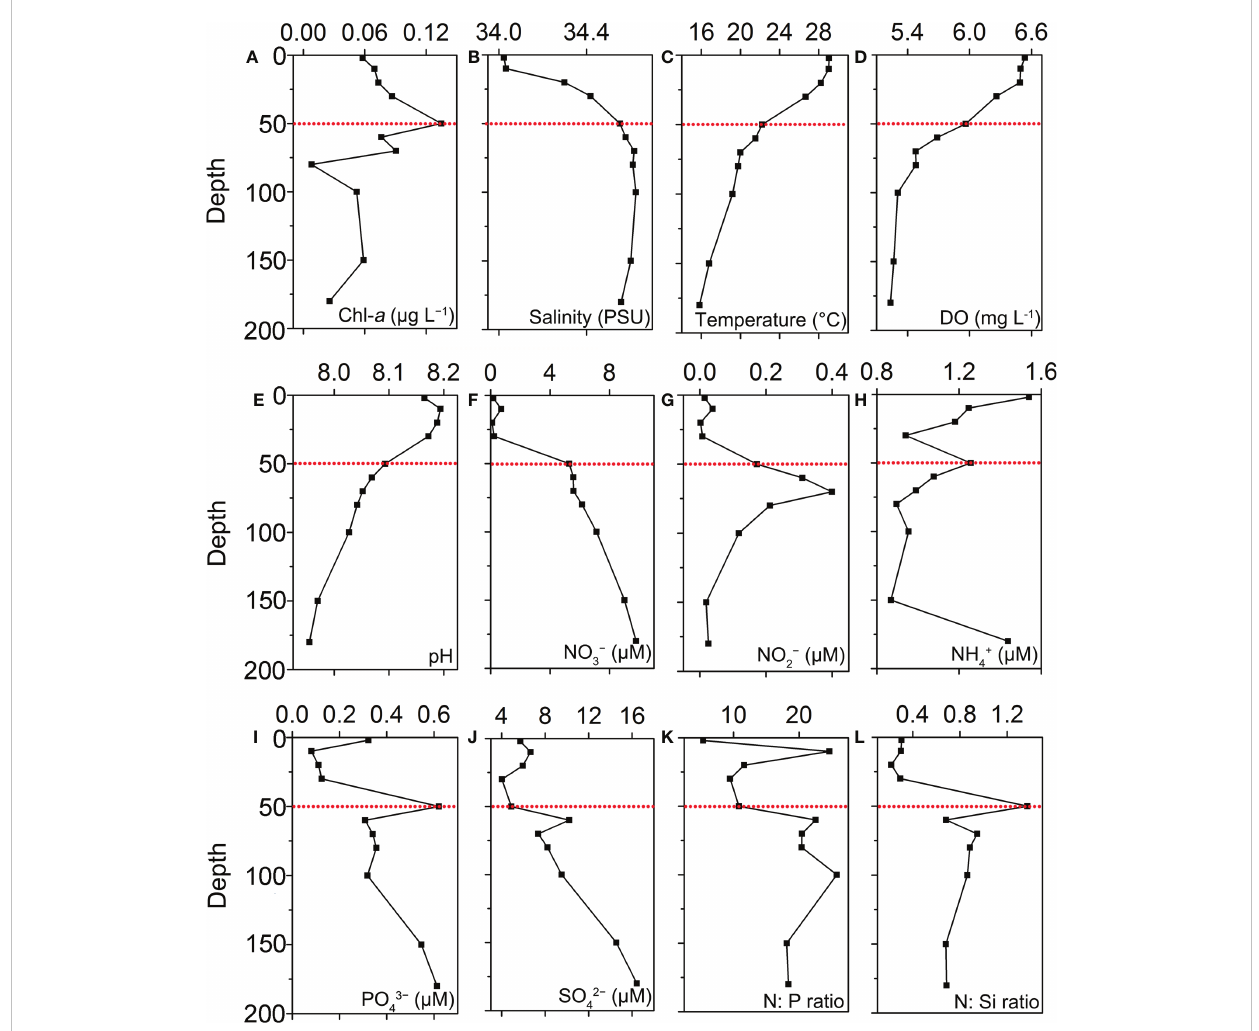
FIGURE 2 Vertical pro fi les of chemical and physical parameters in station B6: (A) total Chl- a concentration; (B) Salinity; (C) Temperature; (D) Dissolved oxygen; (E) pH; (F) NO 3 − ; (G) NO 2 − ; (H) NH 4+ ; (I) PO 43 − ; (J) SiO 42 − ; (K) N:P ratio; (L) N:Si